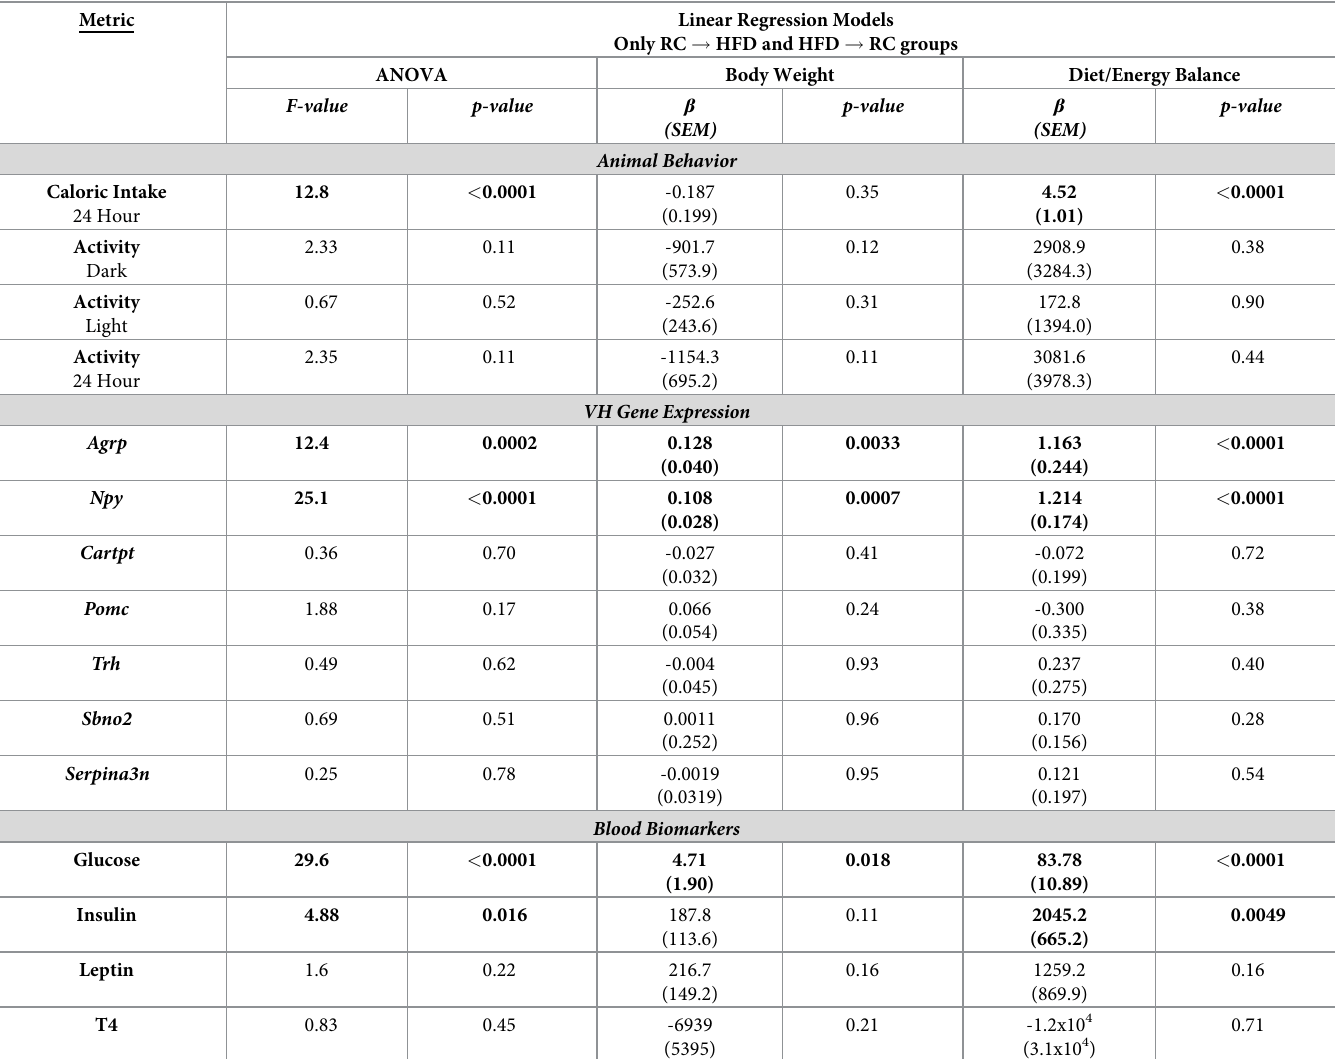
Table 1. Linear modeling results comparing weight-matched DS